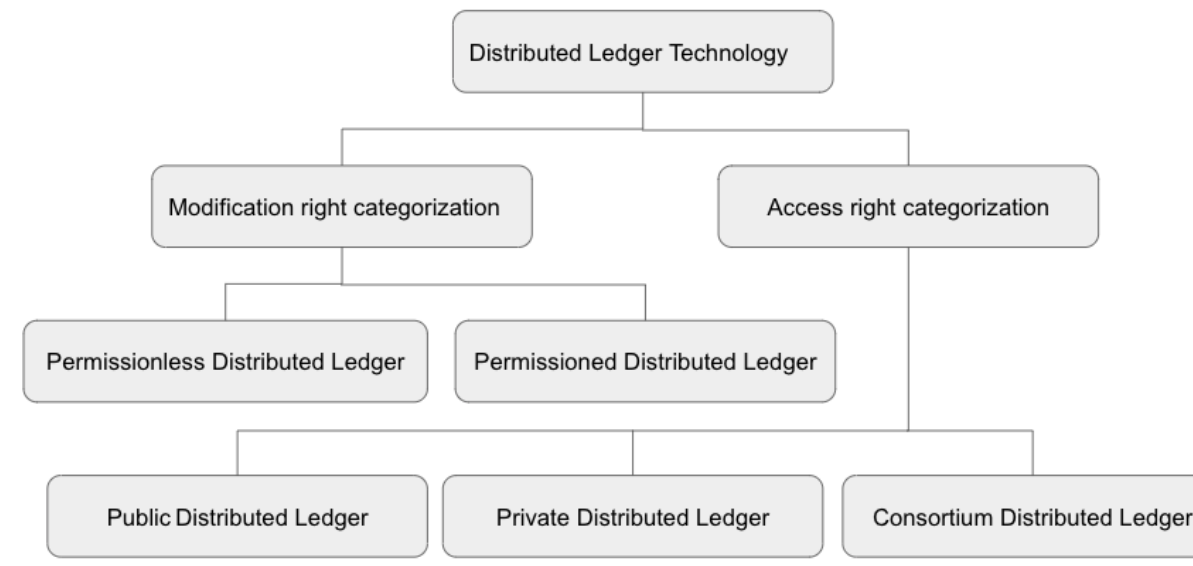
Figure 1. Categorization of DLT based on access and modification rights.